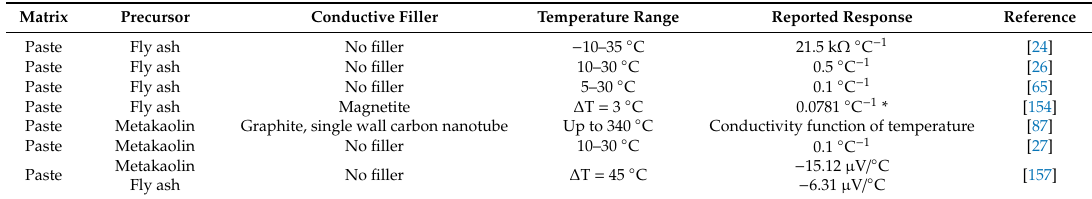
Table 5. Temperature sensing response of